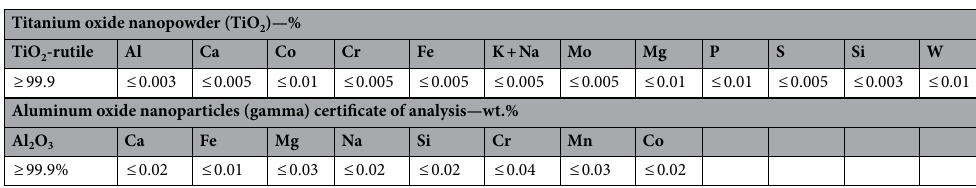
Table 1. Elemental composition based on energy dispersive X-ray spectroscopy (EDX) analysis of nanoTiO 2 and γ-Al 2 O 3